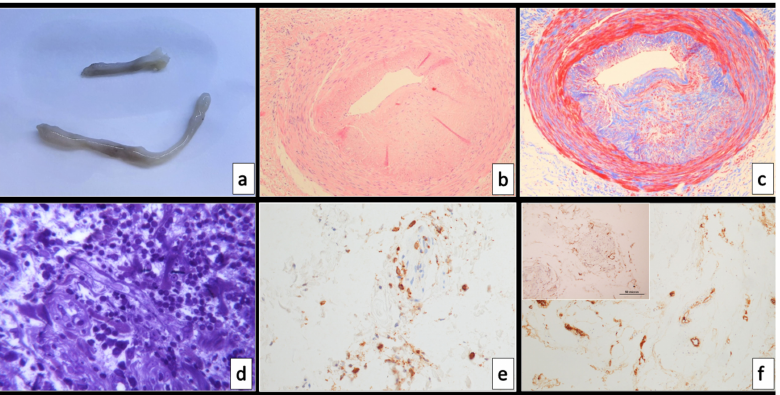
Figure 1. Morphology of the case report. ( a ) Macroscopical appearance of one of the arterial segments examined; hematoxylin–eosin ( b ) and Mallory’s trichrome ( c ) stains: the arterial lumen is reduced by a moderate myointimal thickening, characterized by a scarce cellularity and very mild intimal inflammation. ( d ) Chronic inflammatory infiltrate in the adventitial perivascular tissue, at semi- thin sections, mainly composed by CD3-positive lymphocytes ( e ). Adventitial neoangiogenesis is immunoreactive for FVIII ( f ) and expresses ACE2 receptor as well (insert). Magnification 2 × ( b , c ) and 20 × ( d – f